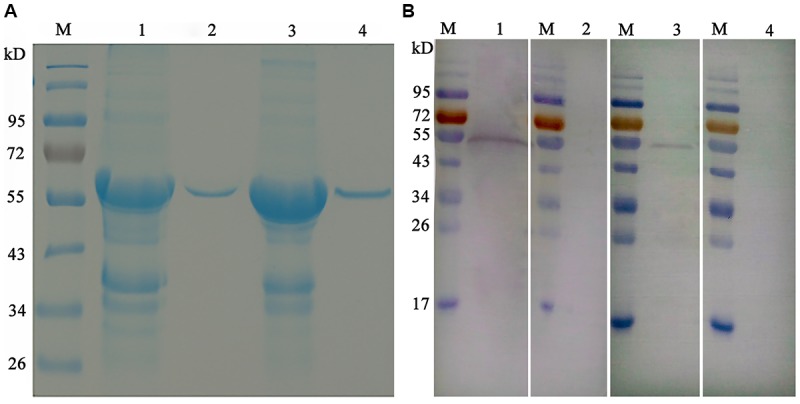
Purification and Western blot analysis of recombinant proteins of EaGAPDH and EmGAPDH with anti-Eimeria chicken sera. Lane M: standard protein molecular weight marker; (A) Purification of EaGAPDH and EmGAPDH; lane 1: Inclusion body extracted from pET32a-EaGAPDH transformed E. coli; lane 2: EaGAPDH purified through Ni2+-charged column chromatography; lane 3: Inclusion body extracted from pET32a-EmGAPDH transformed E. coli; lane 4: EmGAPDH purified through Ni2+-charged column chromatography; (B) Western blot analysis of recombinant proteins of EaGAPDH and EmGAPDH; lane1: EaGAPDH recognized by anti-E. acervulina chicken serum; lanes 2 and 4: EaGAPDH recognized by serum of uninfected chicken; lane 3: EmGAPDH recognized by anti-E. maxima chicken serum.